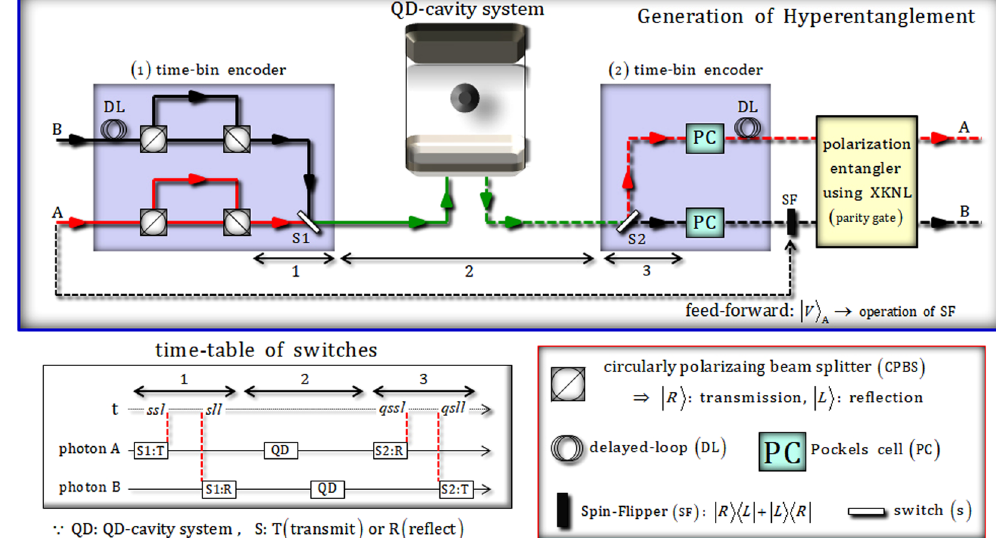
Figure 3. In our proposed scheme, the input state (product state) of two photons is encoded for two DOFs (polarization and time-bin) via (1) the time-bin encoder, which consists of CPBSs and delayed-loop (DL). Then, after the QD-cavity system (nonlinear part) in Sec. 2, (2) time-bin encoder based on PCs 10,16,20,23,75 and DL can encode to polarizations (product state) and time-bin (entangled state) in two photons, respectively, where the switches (S1 and S2) in the time-bin encoders are operated according to a time-table. Subsequently, the polarization entangler parity gate (nonlinear part) using XKNLs completes to generate hyperentanglement having correlations for two DOFs (polarization and time-bin) in two photons (A and